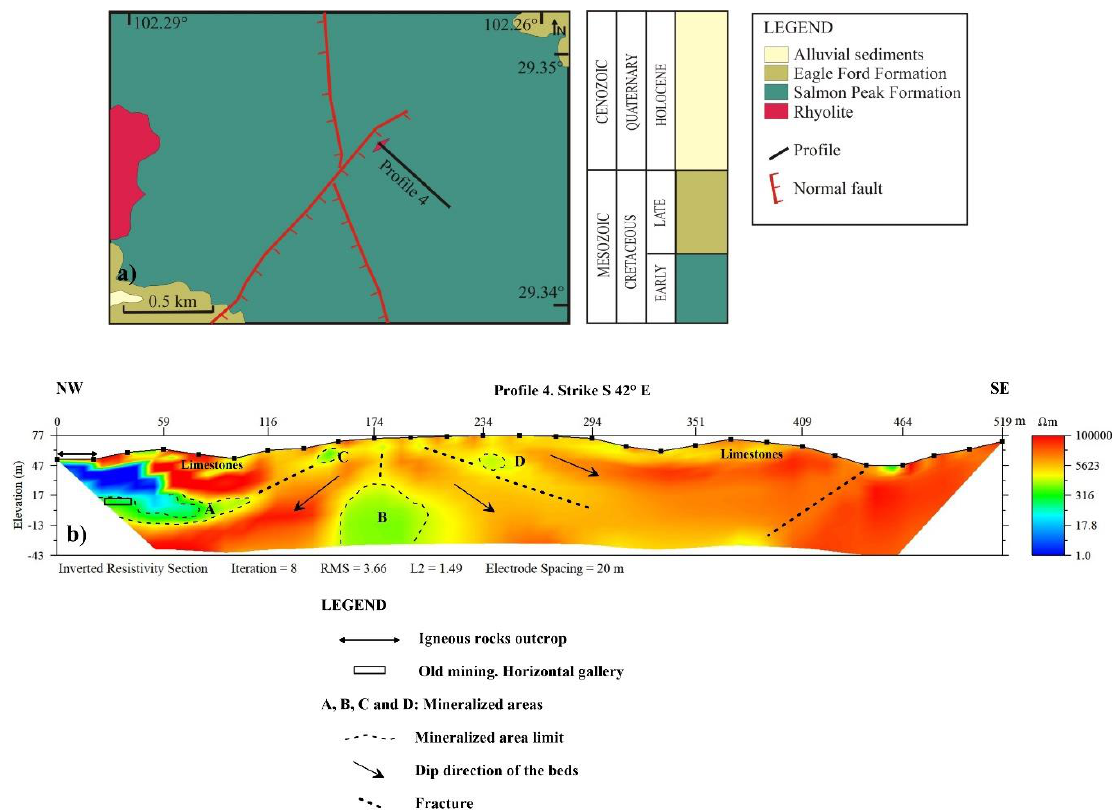
Figure 8. ( a ) Geological map of the Juan Valencia mine. Modified from Bernales-Azúcar et al. [20]. ( b ) Inverted resistivity section. ERT in a magmatic-type fluorite deposit. The stratigraphic column is not to scale.